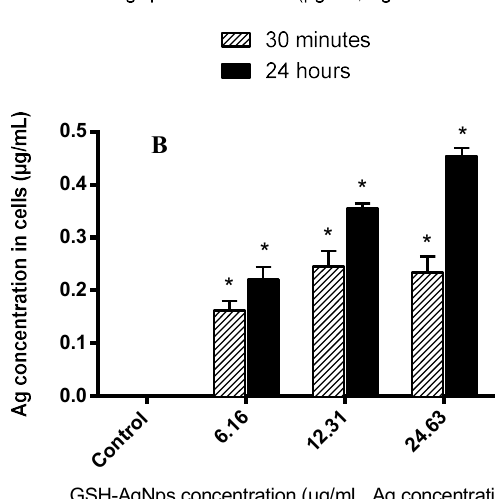
Figure 3. Ag concentration in HGF-1 cells after exposure for 30 min and 24 h to GSH-AgNPs: ( A ) % cellular uptake of Ag (respect initial concentration) and ( B ) Ag concentration (μg/mL). The results are presented as mean ± standard deviation. * Significant differences respect to the control ( p < 0.01).